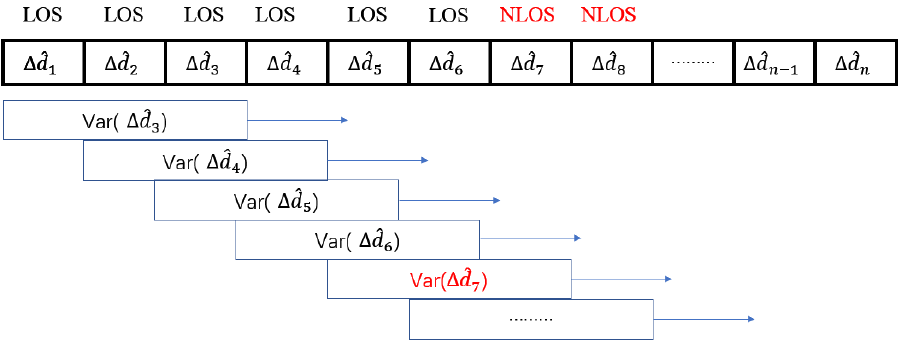
Figure 3. Sliding window method for NLOS identification.